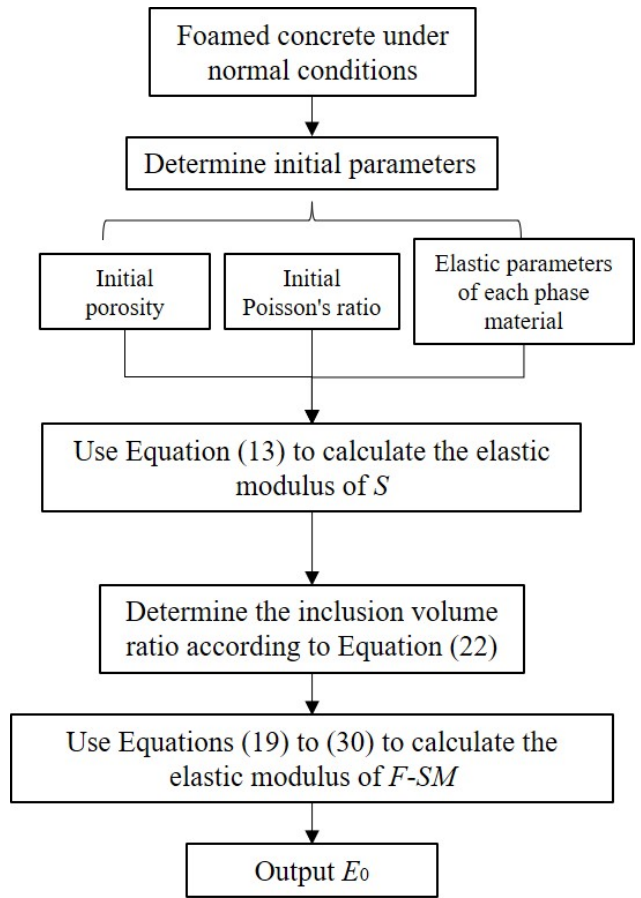
Figure 7. Flowchart of the calculation for the elastic modulus of foamed concrete.